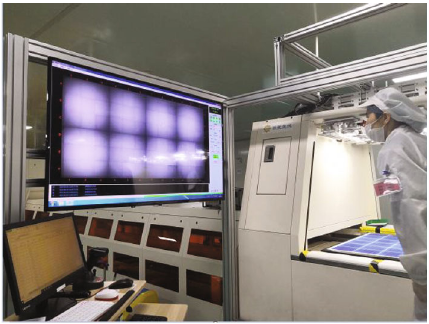
Figure 17: Solar cell component detection site.